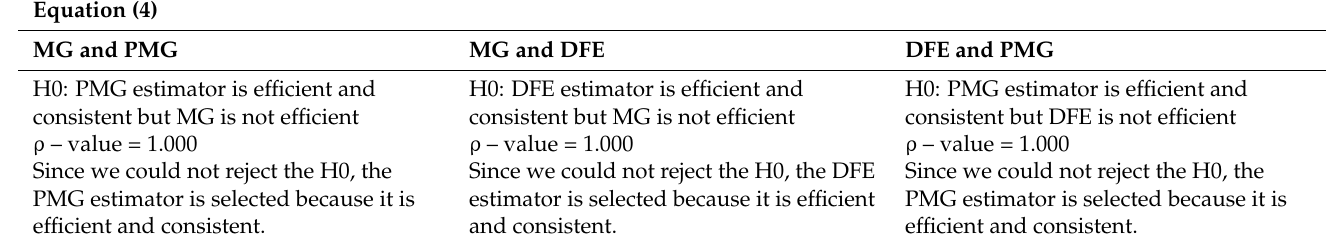
Table 15. Hausman tests for model